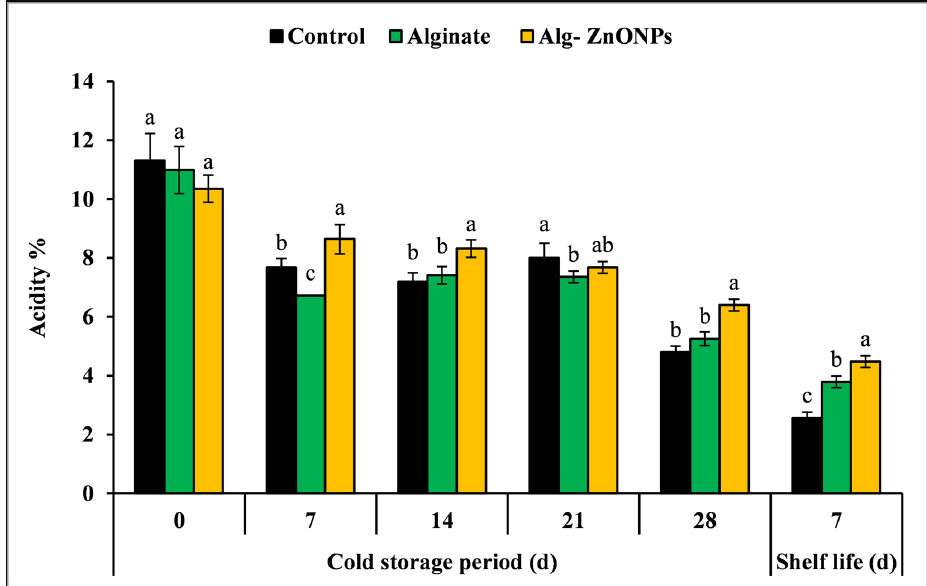
Figure 11. Effect of Alg–ZnO NPs on titratable acidity (TA) of “Kiett” mango fruits during cold storage and shelf life; vertical bars represent the standard error (SE). Bars marked with the same letter in each sampling date are not significantly different with 95% confidence according to Duncan’s multiple range test.